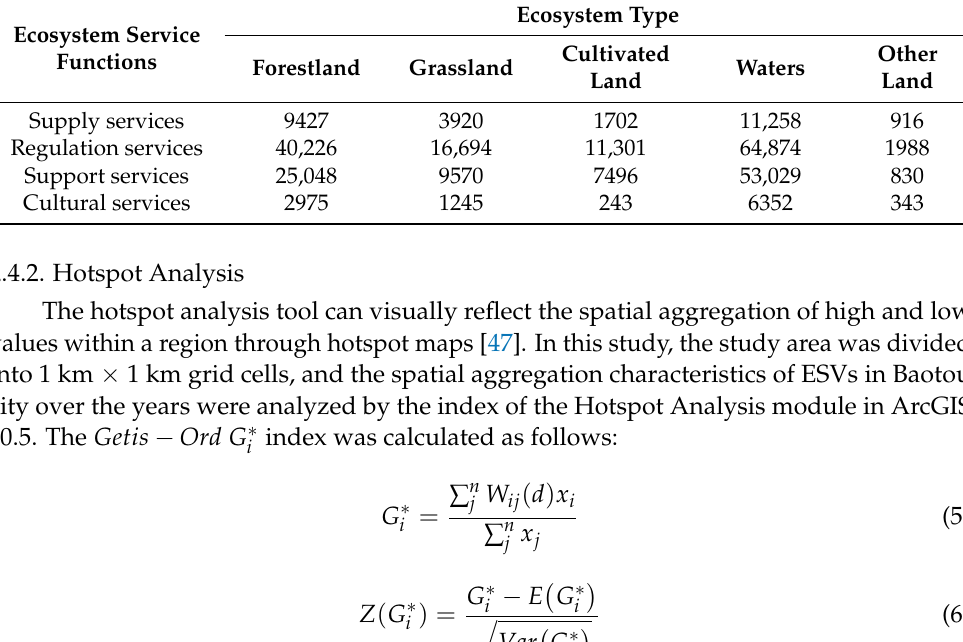
Table 3. Ecosystem service value equivalent per unit area in the study area (CNY/hm 2 · year). Ecosystem